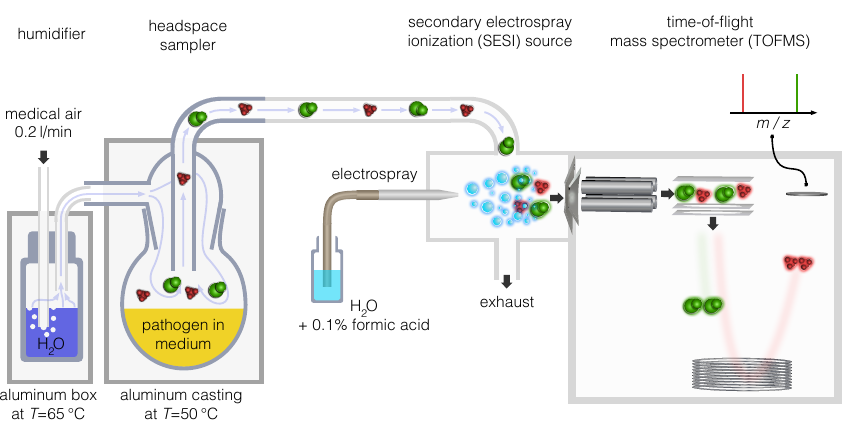
Figure 5. Setup for bacteria continuous headspace analysis with